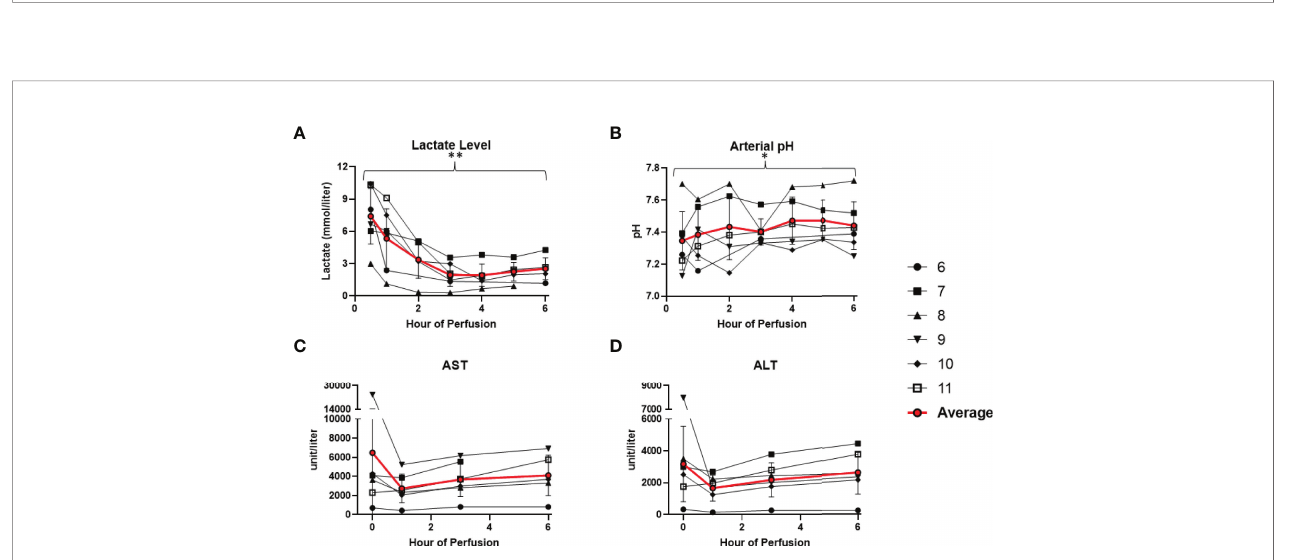
FIGURE 3 | Metabolic parameters improved or remained stable in all 6 livers during normothermic machine perfusion. (A) Lactate level (mmol/liter) decreased during perfusion. (B) Hepatic artery pH normalized during perfusion. (C) Aspartate aminotransferase level (unit/Liter) remained stable. (D) Alanine aminotransferase level (unit/Liter) remained stable. (* P<0.05; ** P<0.01).